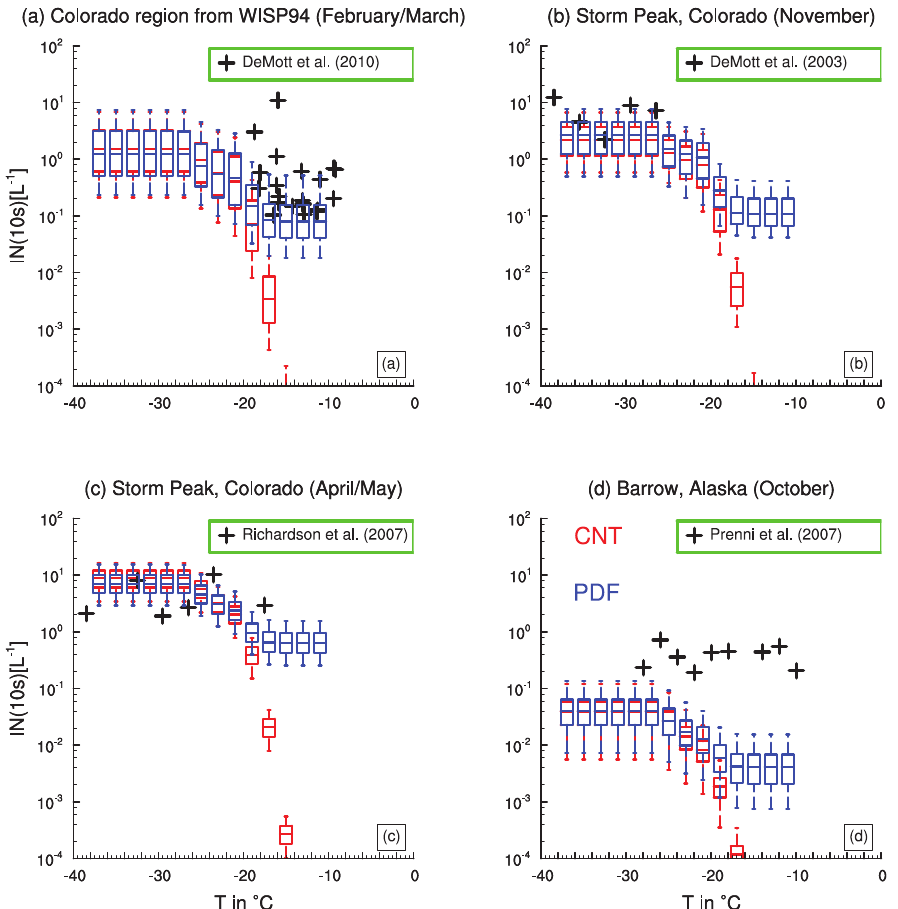
Figure 11. IN(10s) concentrations for specified temperature, selected at the grid points including the measurement locations and at the same pressure level as field observations in the CNT simulation (red boxes and whiskers) and in the PDF simulation (blue boxes and whiskers). The whiskers represent the 5th and 95th percentiles, and the boxes represent the 25th and 75th percentiles and the median. The black crosses indicate CFDC IN measurements.